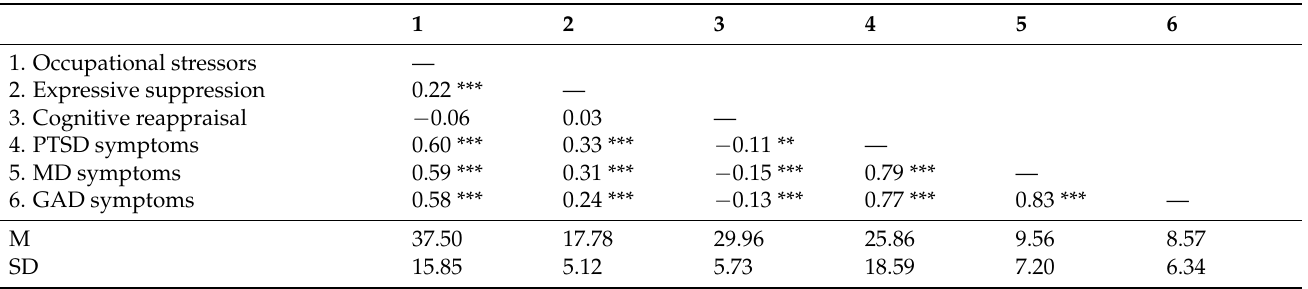
Table 2. Means, standard deviations, and bivariate correlations between key study